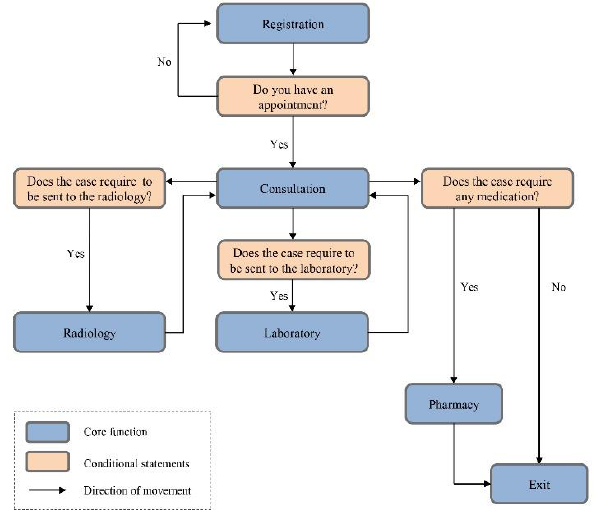
Figure 1. Outpatient units’ high-level workflow based on the MoH’s information management system guidelines [39] illustrates the high-level procedure of handling the cases from an institutional perspective to inpatient and outpatient care in hospitals. PMS focuses on the document’s content pertaining to outpatient cases treatment and referral procedures.